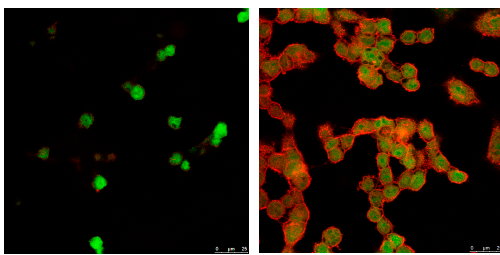
Figure 6. Microscopy confocal images of TC28a2 chondrocyte cells ( green ) incubated with 50 mg/mL of enzyme-NLC ( red ) at 4 °C. Left : 30 min; right : 1 h. of enzyme-NLC ( red ) at 4 ◦ C. Left : 30 min; right : 1